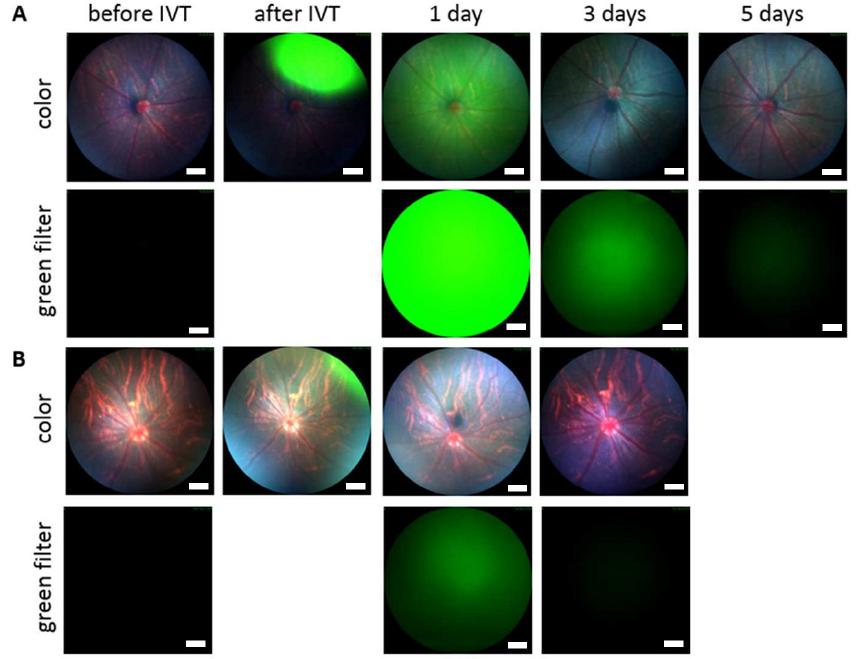
Figure 4. Full color and green fluorescent fundus images of rat eyes before and after intravitreal injection (IVT) of ( A ) BDP-pullulan and ( B ) BDP-pullulan-DEX. After one day, the labeled compounds distribute homogeneously in the vitreous. The length of scale bar is 200 μ m.